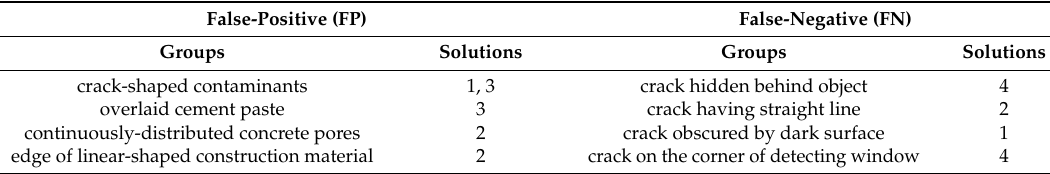
Table 3. Grouping of FPs and FNs, and their possible solutions.